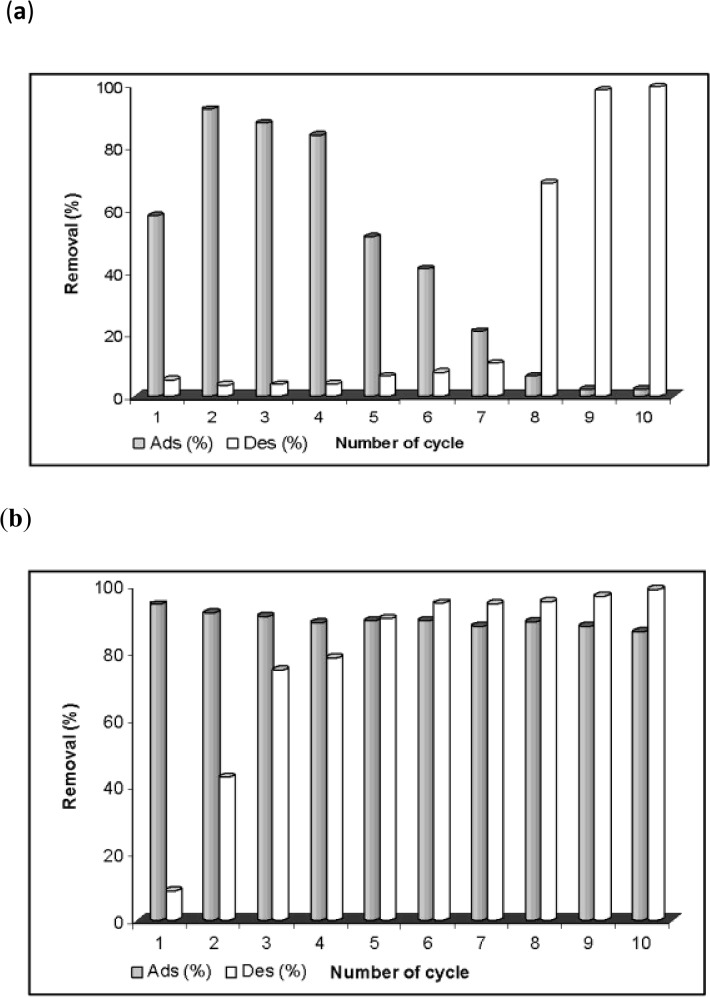
MB adsorption/desorption study on (a) AC and (b) FeAC by using H2SO4 as desorbing agent.